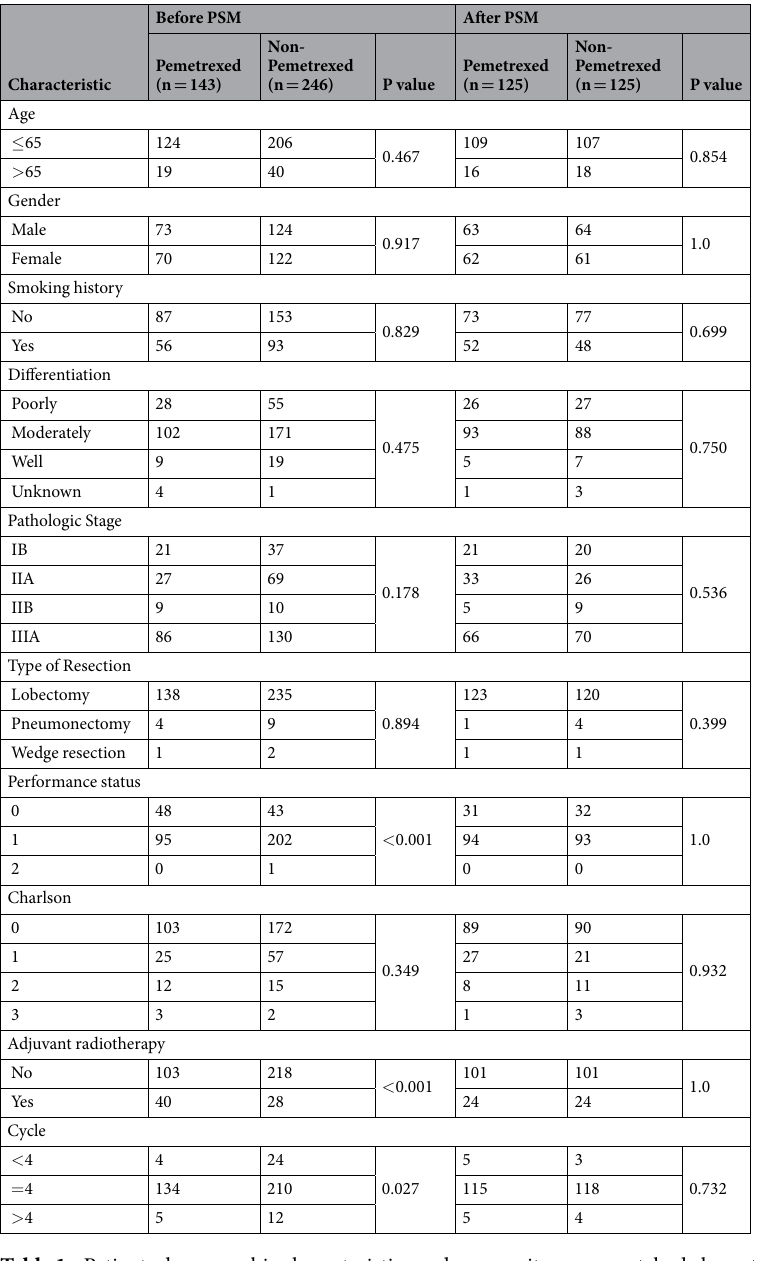
Table 1. Patients demographic characteristics and propensity score-matched characteristics between two